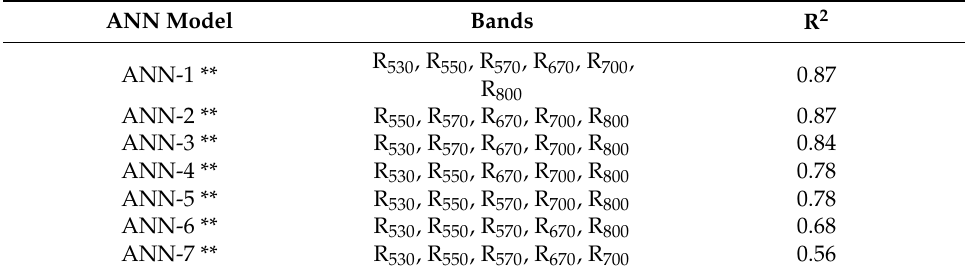
Table 4. Values of coefficient of determination (R 2 ) for the artificial neural network (ANN) model